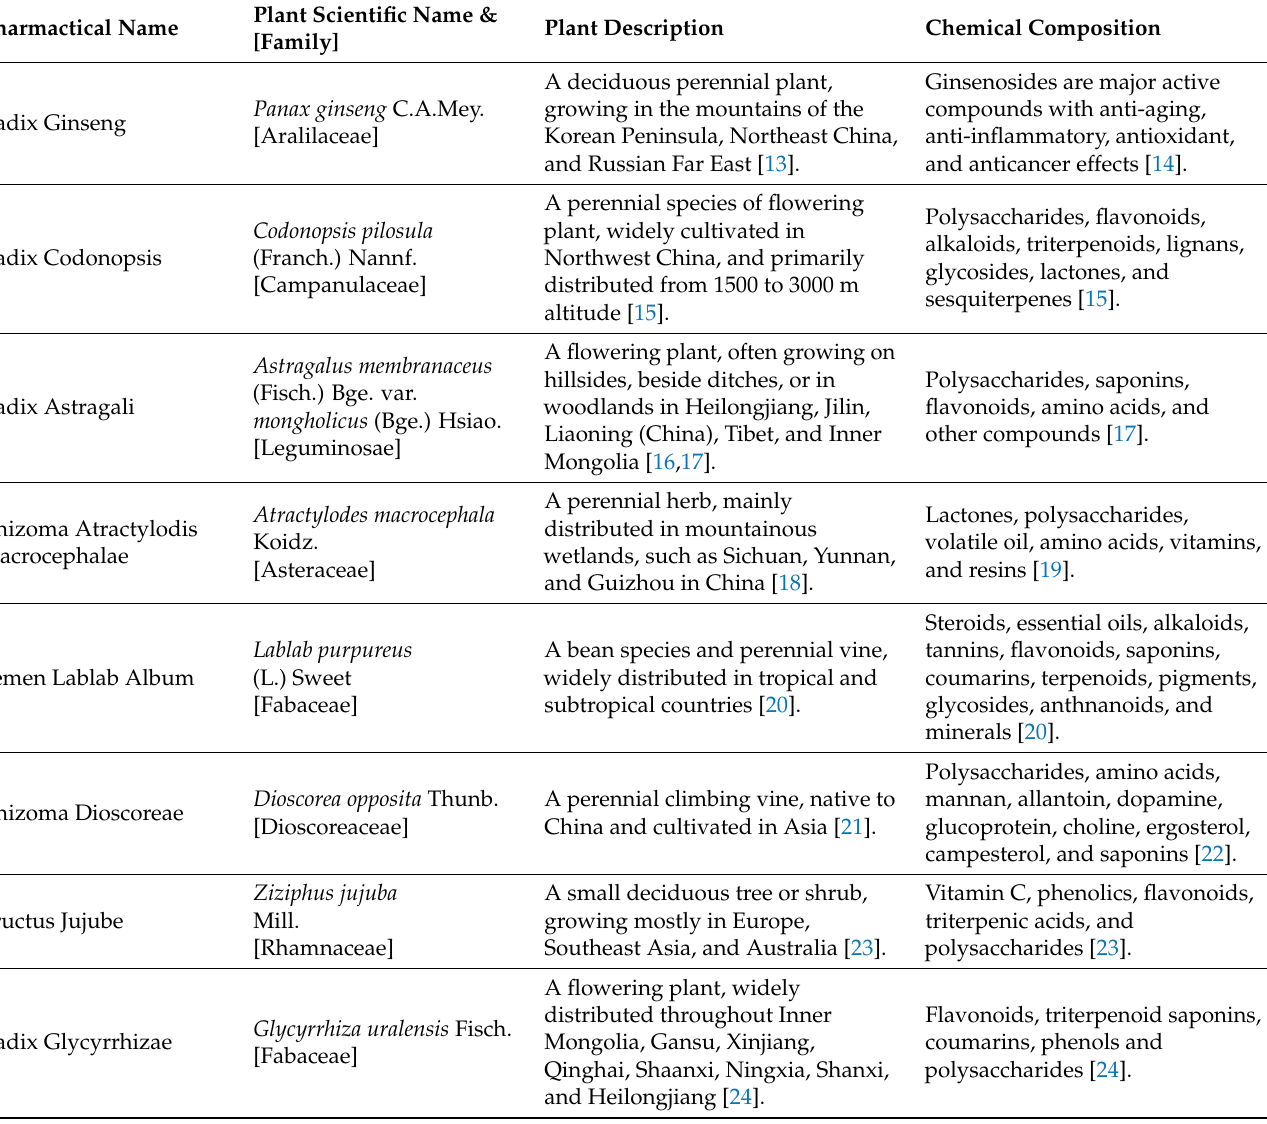
Table 1. Descriptions of the plant species of eight Qi-invigorating herbs.